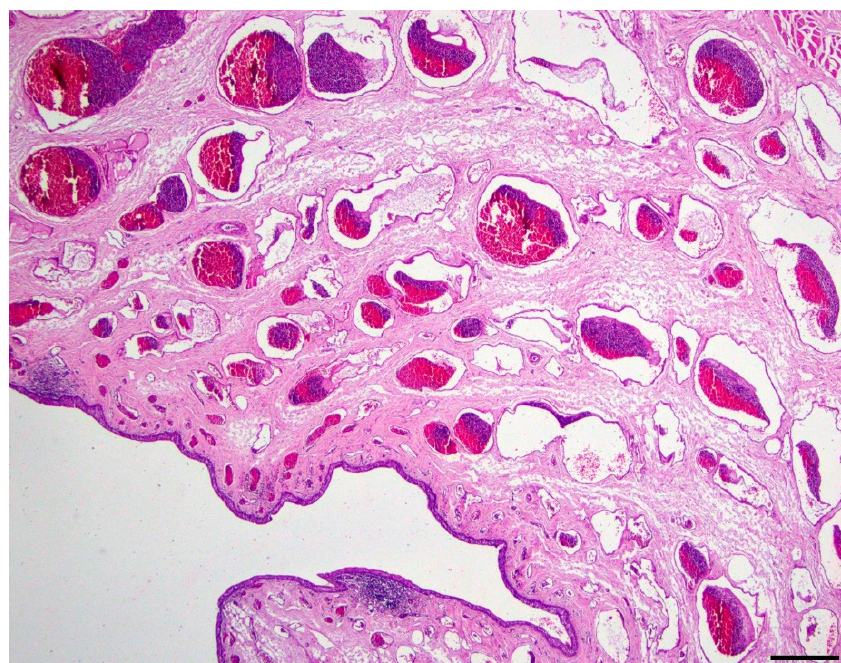
Figure 4. Duplicated urethra, lumen (200x, hematoxylin and eosin). The lumen of the mass is lined by urothelium, which is variably infiltrated by small-to-moderate-sized aggregates of lymphocytes and fewer plasma cells and supported by a fibrovascular stroma containing numerous, variably sized, dilated, blood-filled vascular channels; bar = 100 µm.